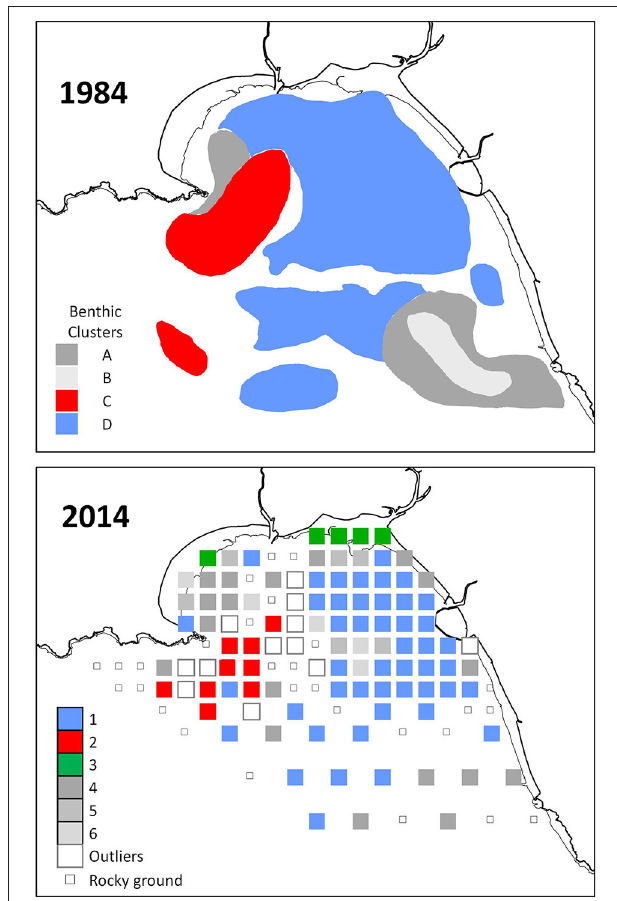
FIGURE 2 | Benthos associations in Swansea Bay delineated by hierarchical cluster analysis based on Bray-Curtis similarities between samples. The 1984 map was adapted from a figure reported by Conneely (1988) (Supplementary Material S1).